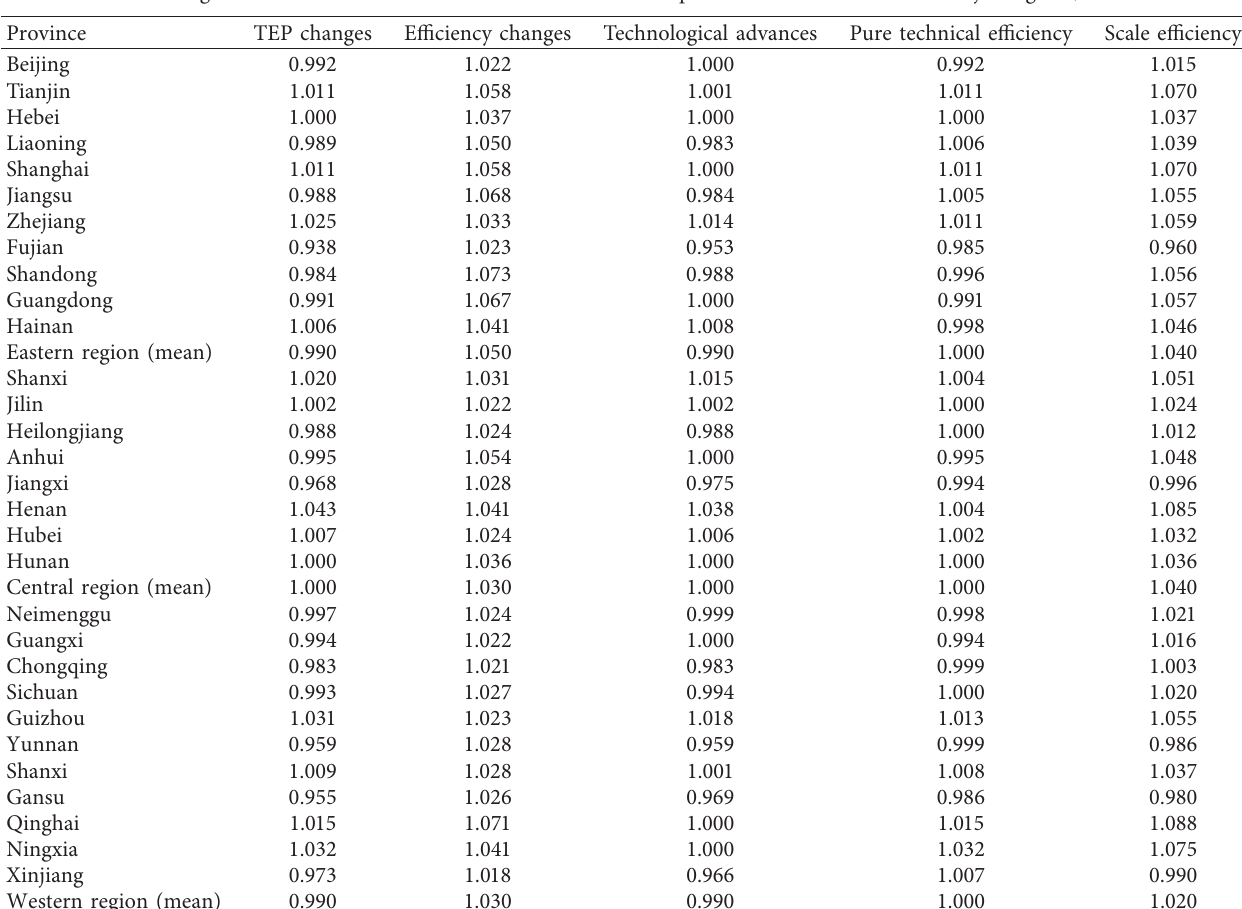
Table 2: Average values of industrial TFP indices and their decomposition indices in the three major regions, 2005–2017. Province TEP changes Efficiency changes Technological advances